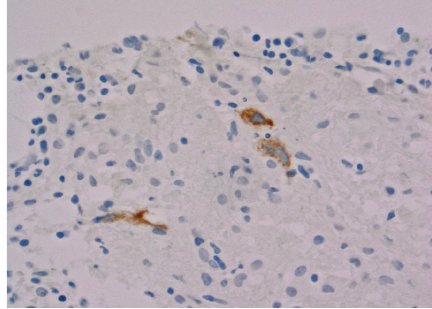
Figure1:Core-needlebiopsyofarightaxillarylymphnoderevealed Reed-Sternberg cells (red circle) in a background of fibrosis and mixed inflammatory infiltrate.